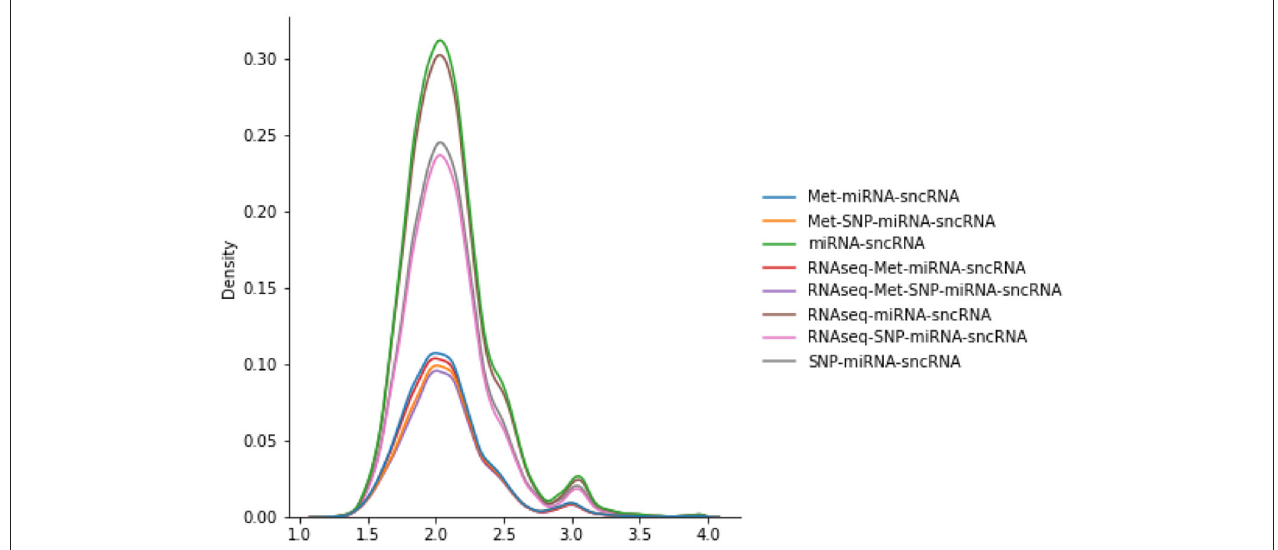
FIGURE 2 | Distributions of various PSGs for DTI-fMRI data, used in the connectome